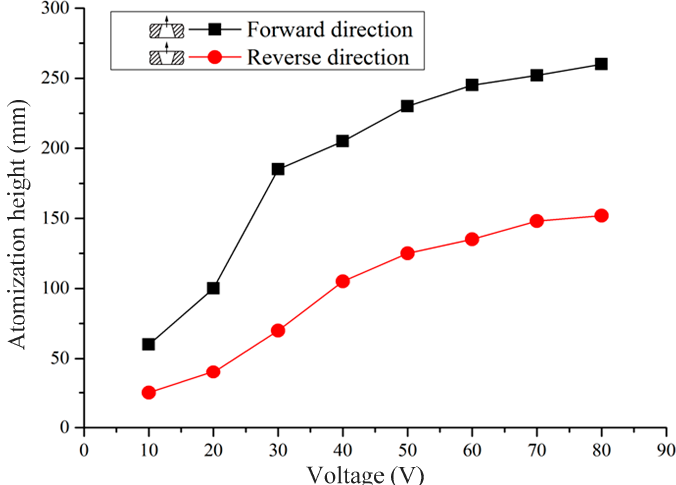
Figure 12. Variation in the atomization heights with working voltage.